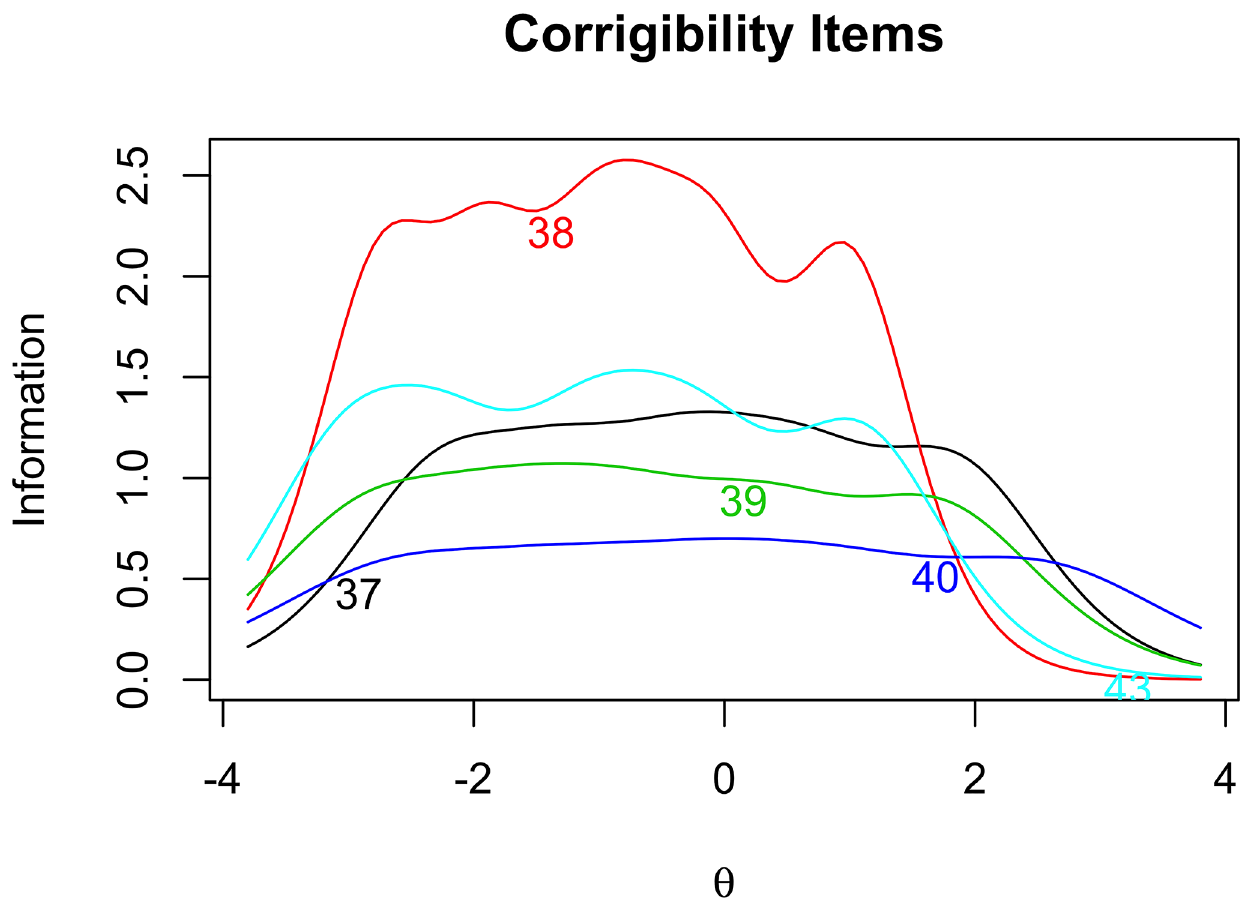
Fig 3. Corrigibility item response analysis. Item informationcurves for